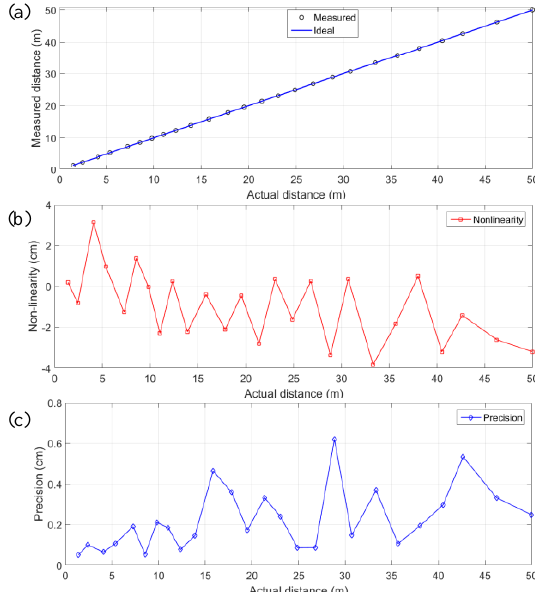
Figure 17. ( a ) Measured distance up to 50 m as a function of the actual distance; ( b ) The maximum